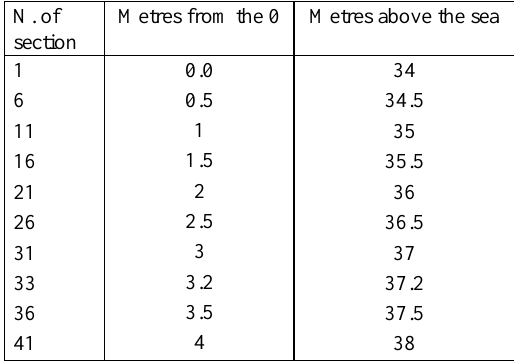
Table 1. Number of sections analysed and high from the sea level and the quote 0 (Pilia E.).